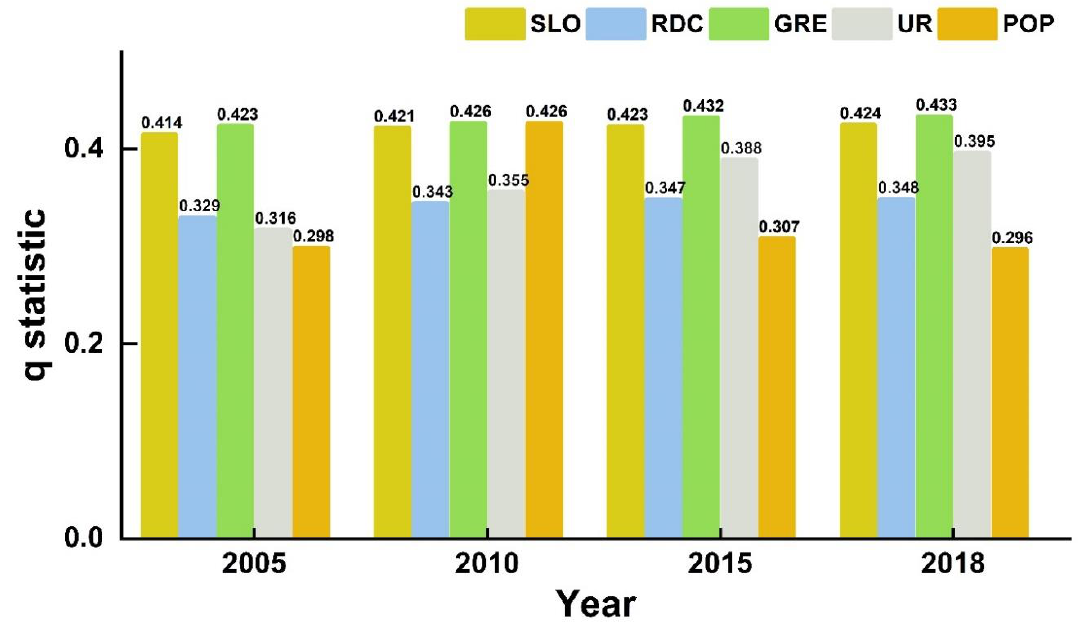
Figure 7. GDM detection q statistic for ESV for five factors. SLO, slope; RDC, river distance accessibility; GRE, per capita green area; UR, the proportion of urban and rural human settlements; POP, population.